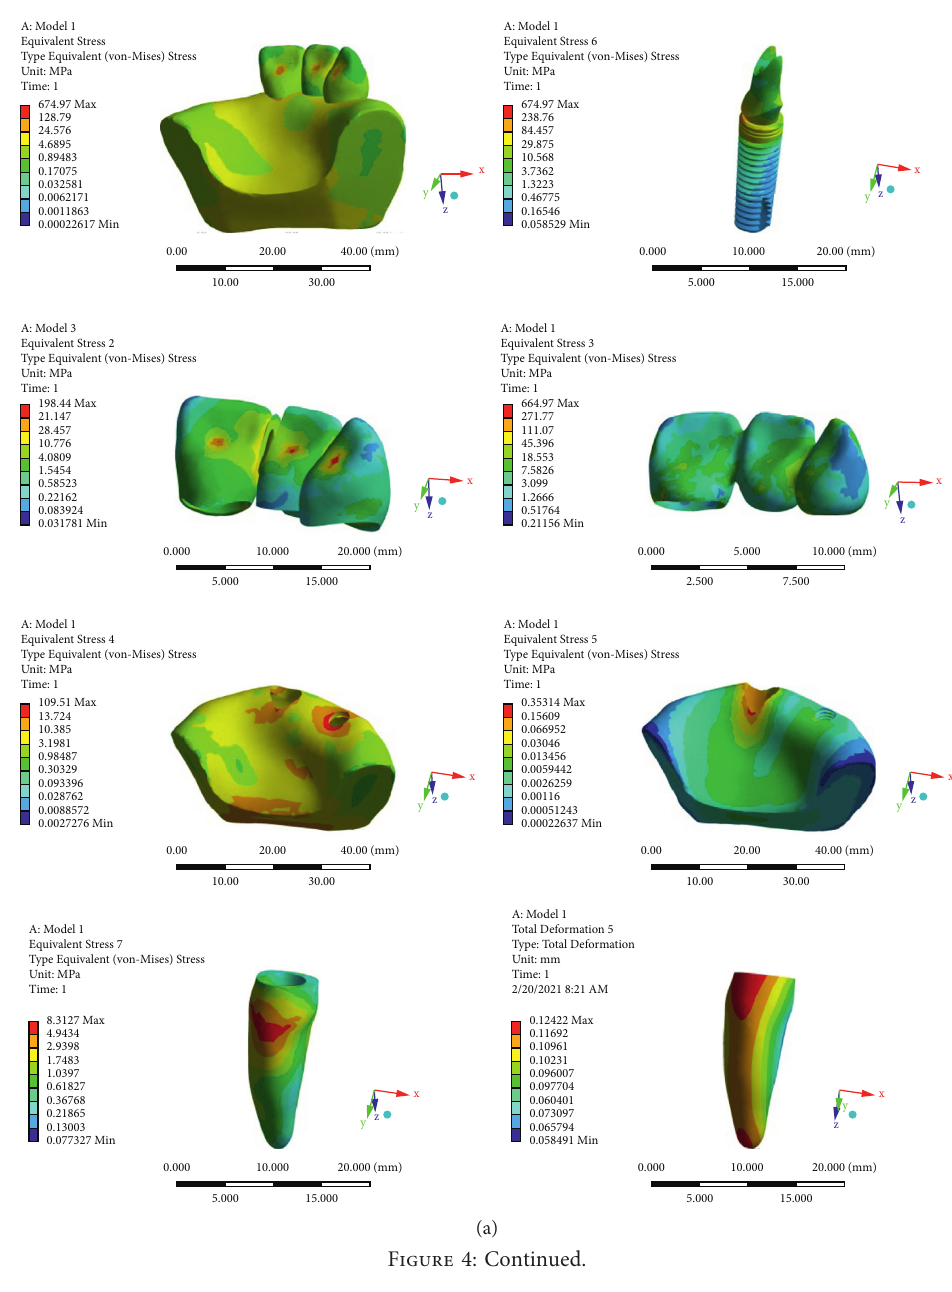
Model 1 Equivalent Stress 4 Type Equivalent (von-Mises)